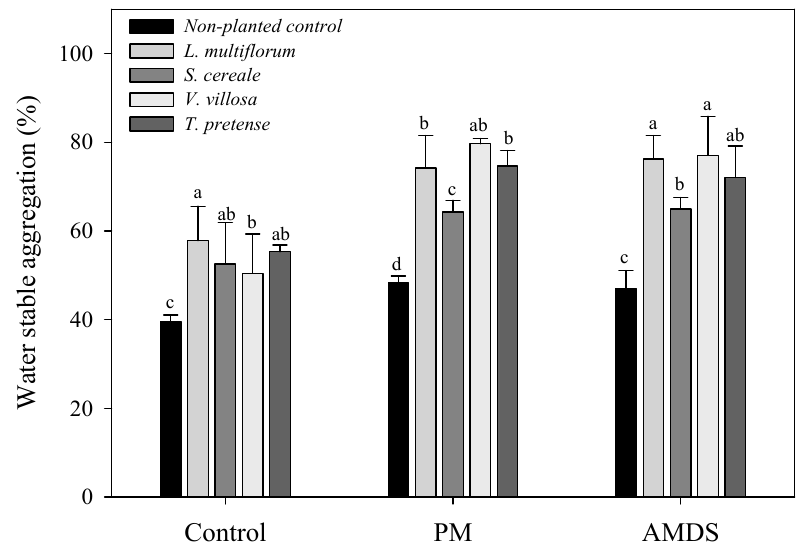
Figure 3. Water stable aggregation of the soils with different types of cultivated plants ( Loliummultiflorum and Secalecereale (Poaceae family representatives) and Trifoliumpratense and Viciavillosa [Leguminosae family representatives]) and amendment treatments (Control; PM, pig manure; AMDS, acid mine drainage sludge). Different letters indicate significant differences among the NPC (nonplanted control) and the four plant species with same treatment, using Tukey’s test. Error bars represent ± standard deviation of three replicates ( n = 3).